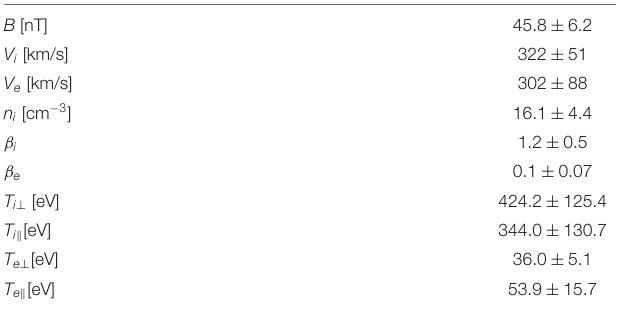
TABLE 1 | Showing the mean and standard deviation of several plasma parameters during the